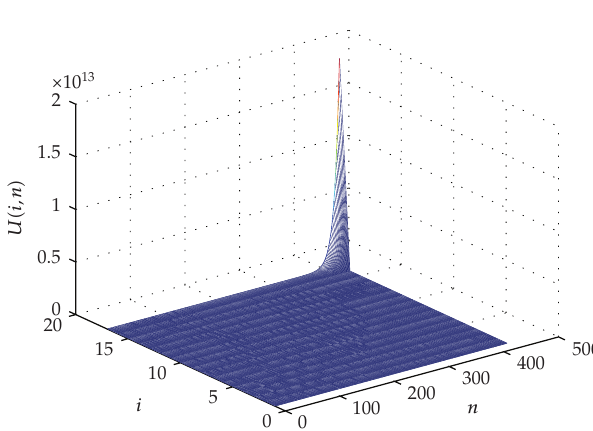
Figure 1: Evolution of the discrete solution, q (cid:2) 2, p (cid:2) 2 (cid:3) explicit scheme (cid:4) .